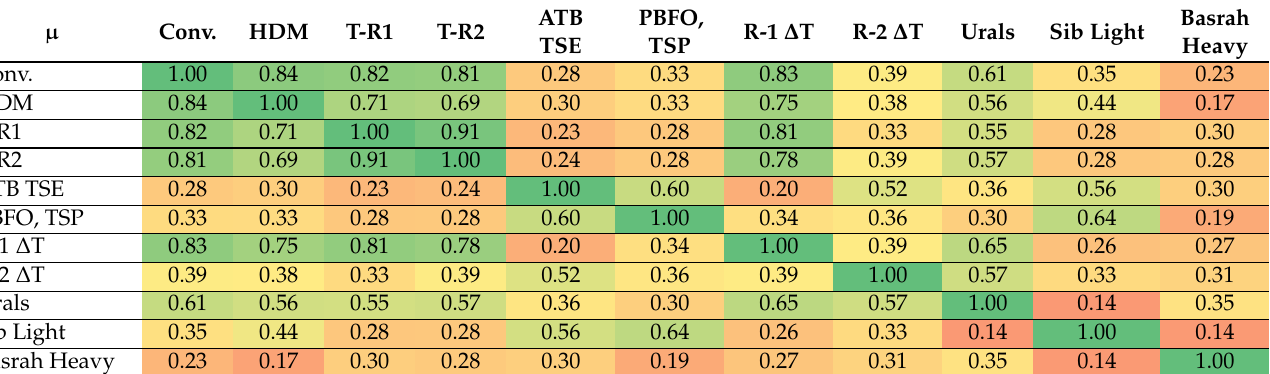
Table 3. µ -value of the ICrA evaluation of relations between the different variables characterizing hydrocracker performance.